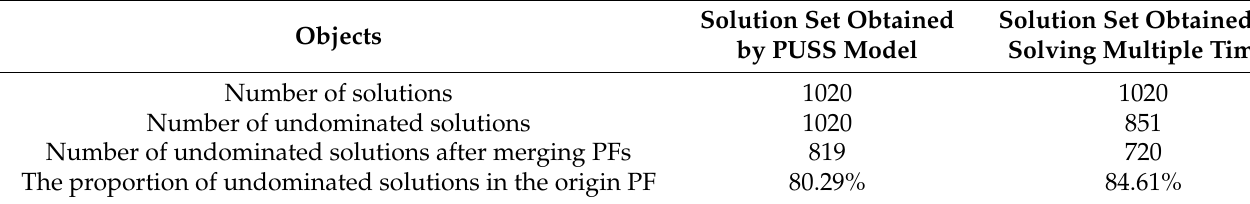
Table 3. Settings of algorithm